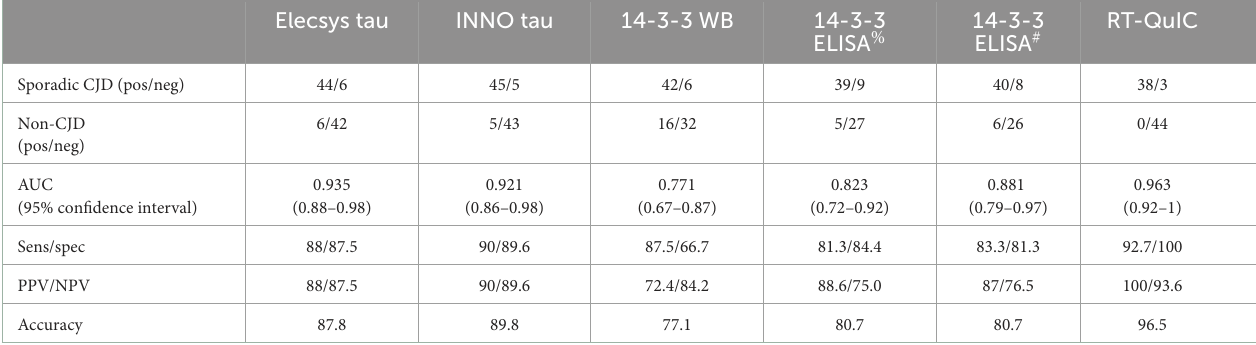
TABLE 3 Summary of diagnostic utility of CSF